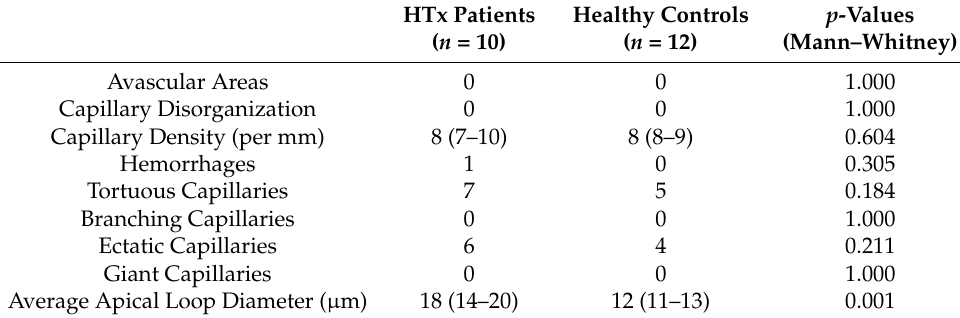
Figure 1. Representative results for nailfold videocapillaroscopy (NVC). NVC was performed using the Dino-Lite CapillaryScope 200 Pro (MEDL4N Pro); 200 × magnification in both pictures. Table 2. Quantification of NVC pattern comparing HTx vs. healthy controls.